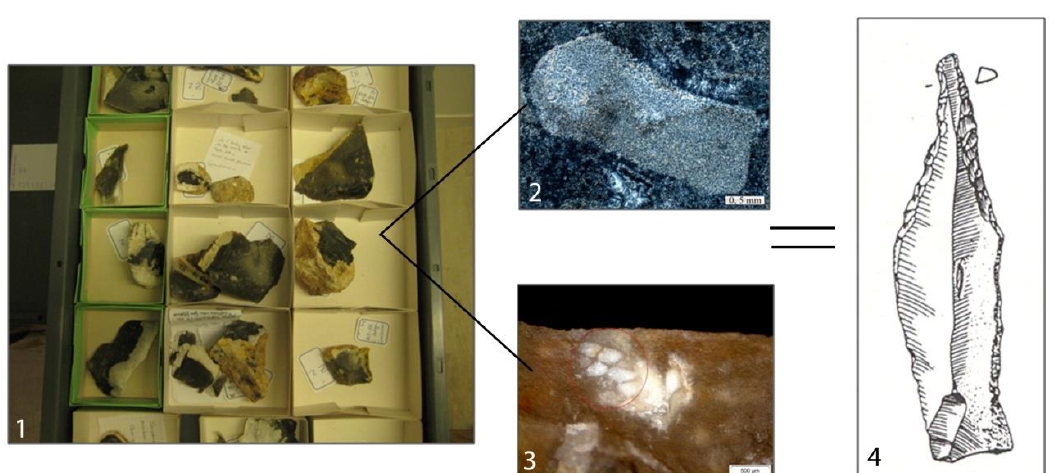
Figure 6. Simplified scheme for the next archaeopetrological study of comparison of geological and archaeological samples of Chaire-à-Calvin. 1. The lithothèque. 2. Microscopic photography of an echinoderm plate. 3. Macroscopic photography of thecal plates of a crinoid, both from La Couronne outcrop (Upper Turonian). 4. Perçoir from